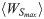
Heatmap showing top 50 ranked highly conserved ortholog groups for Caulobacteraceae and Hyphomonadaceae families.Each column designates a species, following the order dictated by a phylogenetic tree inferred from a multiple sequence alignment of GcrA homologs. Rows correspond to identified orthologous groups. For each cell, the cyan-yellow scale coloring indicates the posterior probability of regulation of the ortholog in that species (cyan blue—1, yellow—0). White cells indicate absence of the ortholog in that particular species. The left ancillary columns indicate, using the same color scale, the number of orthologs in each ortholog group (lowest value 20 out of 23) and the inter-species average of best extended GANTC instance score 〈WSmax〉, which has been used to rank the ortholog groups. Both values are shown normalized to the (0,1) range. The right ancillary columns indicate the two primary functional categories for the COGs assigned to each ortholog group, the description and identifier of which is shown adjacent. Highlighted descriptions denote ortholog groups also present in Fig 6.